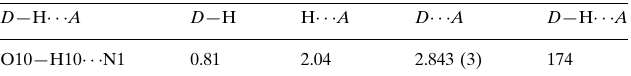
Hydrogen-bond geometry (A˚ , (cid:4)